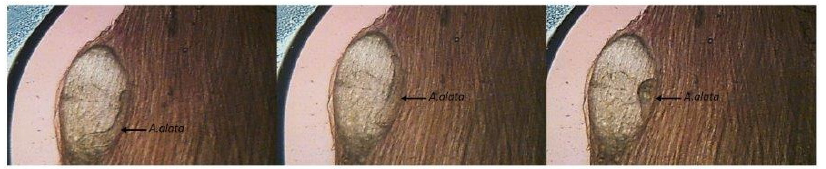
Figure 4. A. alata movement sequence in a muscular cyst of a wild boar (by M. Ró ż ycki) (the movie showing movement of A.alata is included in the Supplementary Materials Video S1).